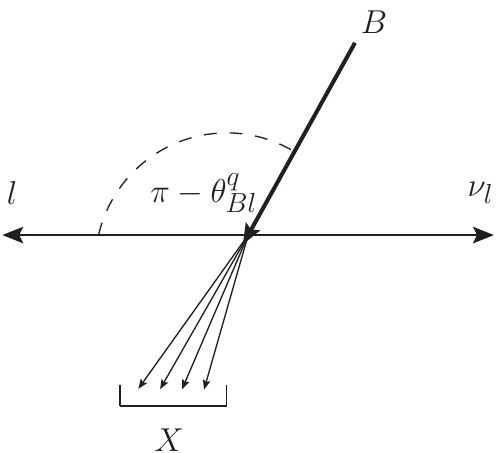
Figure 1: The decay of a B meson into a lepton l , a neutrino ν system X in the lepton-neutrino rest frame. The angle between the flight direction of lepton and B meson is θ q